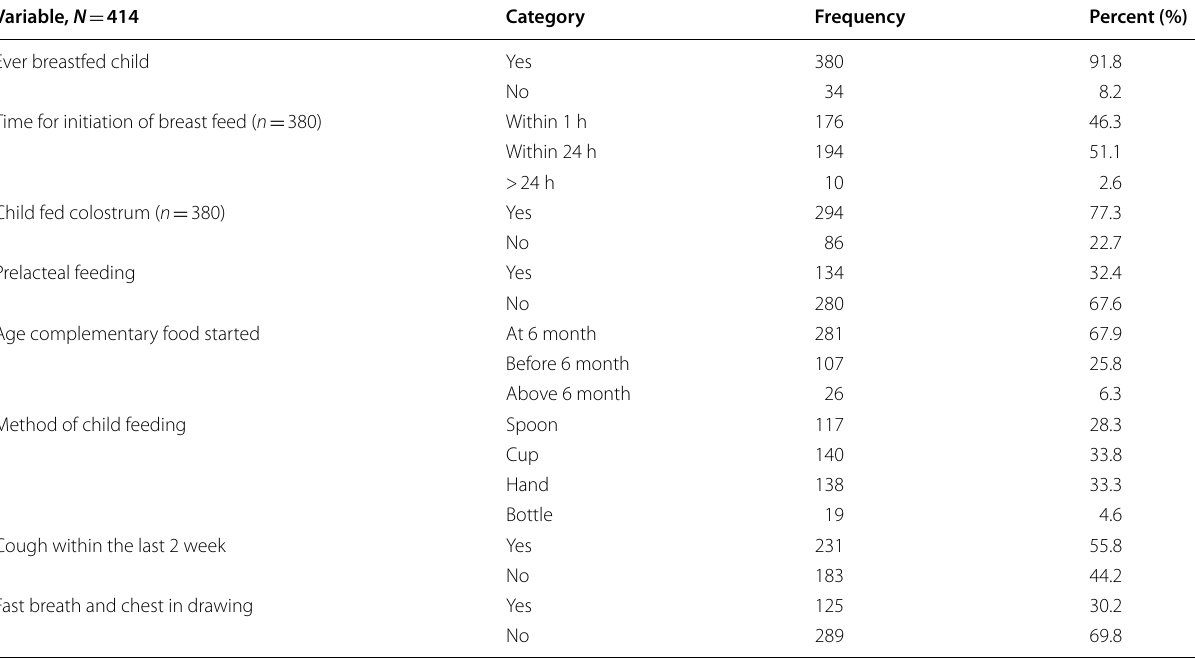
Table 3 Dietary characteristics of children among 6–59 months in Angolalla Tera